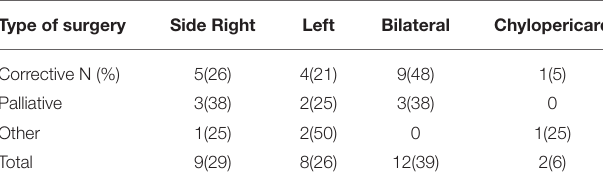
TABLE 3 | Chest tube